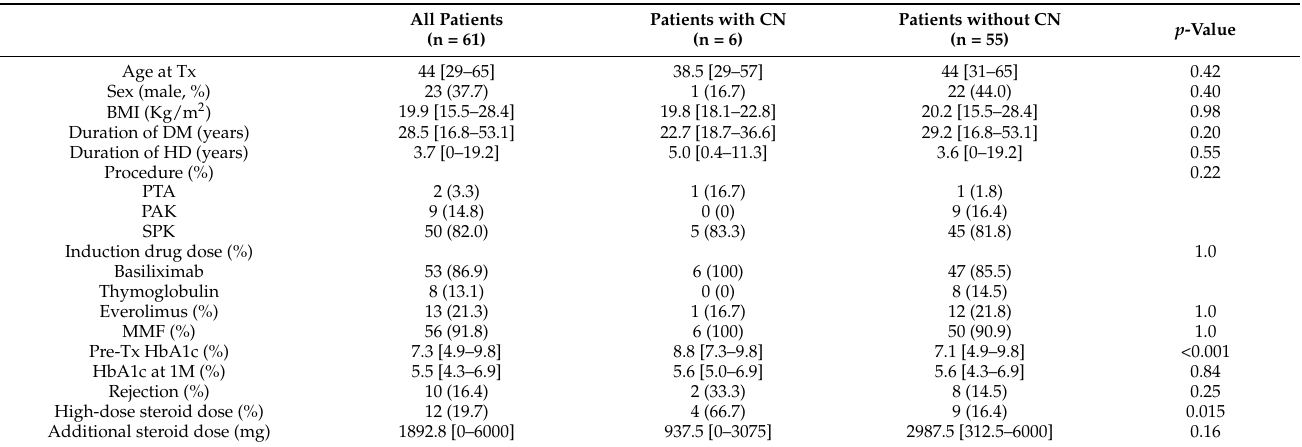
Table 1. Patient background